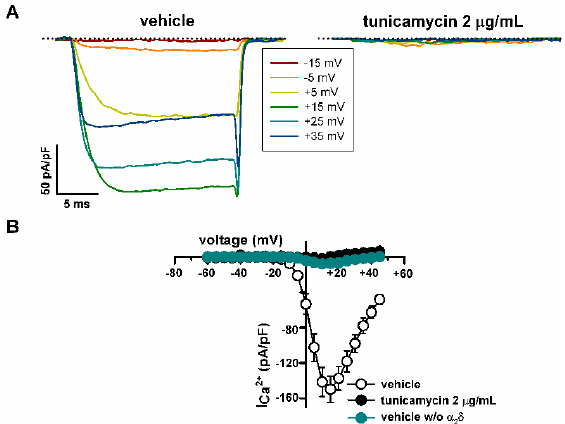
Figure 3. Inhibition of N -glycosylation strongly reduces functional expression of Ca V 2.1 channels containing β 3 and α 2 δ 1 subunits, heterologously expressed in HEK293 cells. ( A ) Representative current traces elicited by 20 ms depolarizing pulses from − 80 mV to the indicated voltages (inset), illustrating the significant (see Results) reduction in Ca 2+ current amplitude through Ca V 2.1 channels induced by tunicamycin (2 μ g/mL) versus vehicle (DMSO) treatment. The zero current level is indicated by dotted lines. ( B ) Average Ca 2+ current density-voltage relationships for DMSO-treated cells in the presence (open circles, n = 27) and in the absence ( w / o ) (filled cyan circles, n = 7) of the α 2 δ 1 subunit, and for tunicamycin-treated cells (filled black circles, n = 6). No significant differences on the maximal current density between cells treated with tunicamycin and cells lacking α 2 δ 1 were observed (Kruskal-Wallis test followed by Dunn post hoc test).